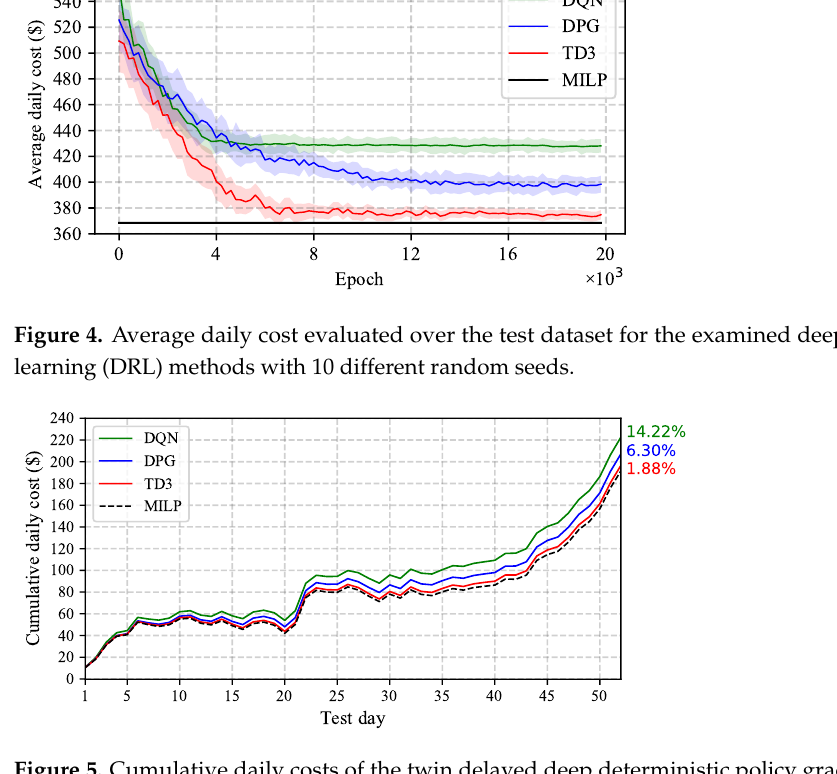
Figure 5. Cumulative daily costs of the twin delayed deep deterministic policy gradient (TD3) and all the baseline methods over the 53 test